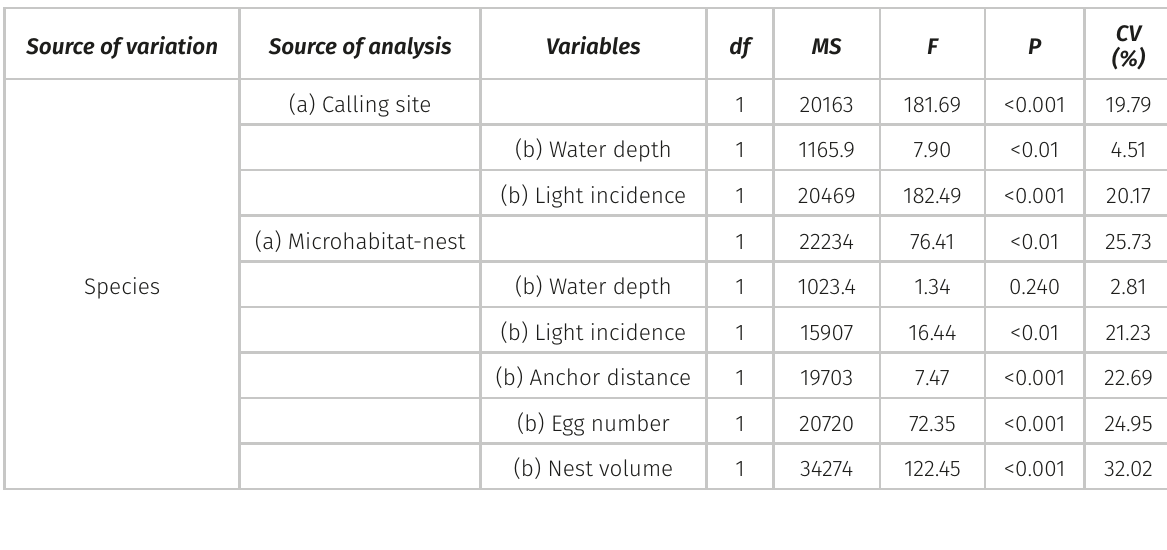
Table II. Permutational (a) MANOVA and (b) ANOVAs based on the Bray–Curtis similarities of the multivariate data on calling sites and microhabitat-nest variables from P. aff. albonotatus and P. santafecinus . The component of variation (CV) attributable to each source of variation is also shown.